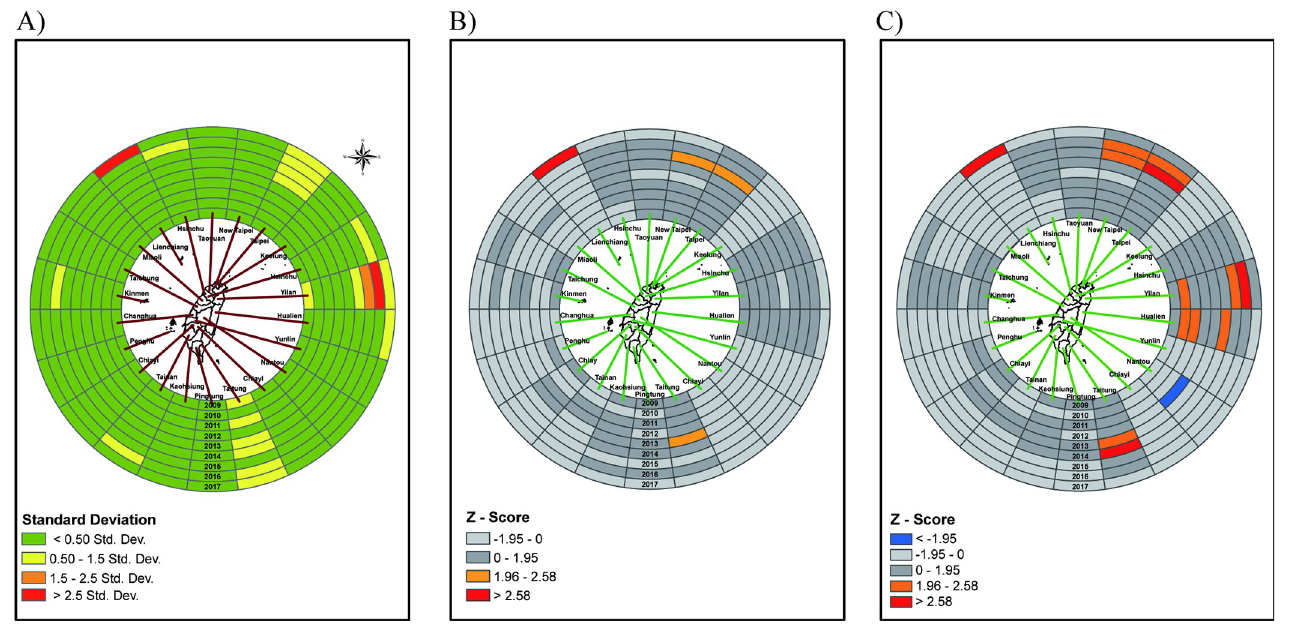
Fig 3. Ring map of outpatient visit rate of scarlet fever in age group 5–9 years. (A) A Z score ring map from innermost in 2009 to outermost in 2017. (B) A ring map of Z-scores by applying spatio-temporal G